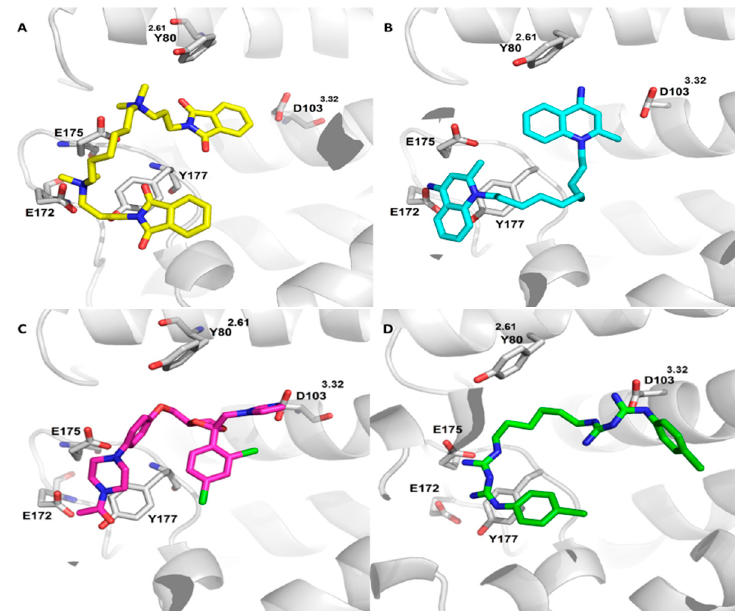
Figure 2. Putative complexes as computed by docking simulations for (yellow carbon atoms, ( A ) W84, (azure carbon atoms, ( B ) dequalinium, (purple carbon atoms, ( C ) ketoconazole and (green carbon atoms, ( D ) chlorhexidine within the hM 2 binding sites in its active state (PDB Id: 4MQT). In all figures, the loop between residues 411 and 418 was not displayed for sake of clarity.